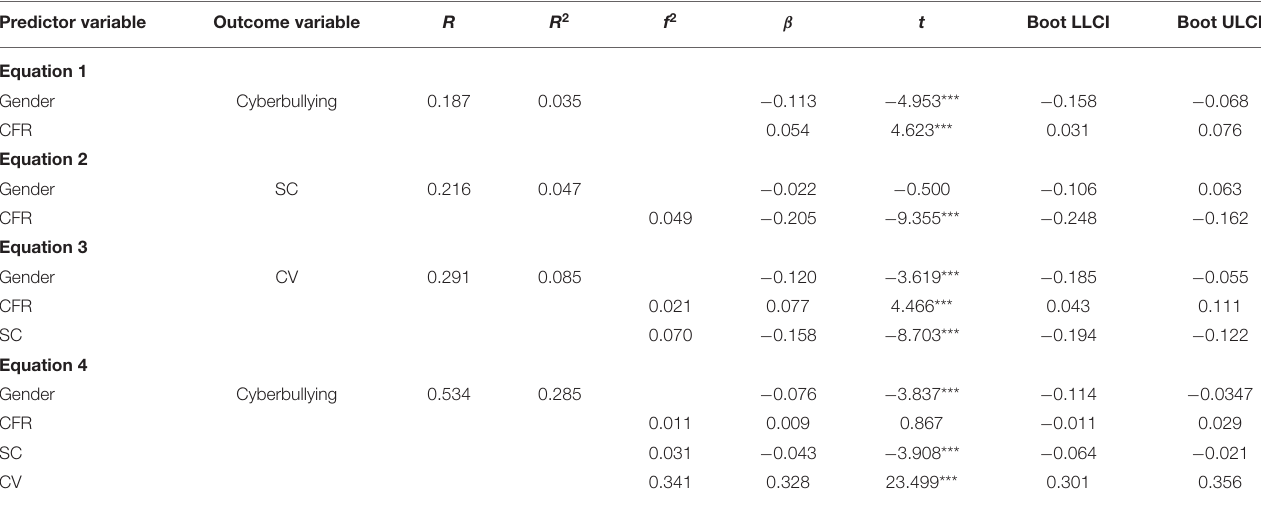
TABLE 3 | Regression results for the conditional indirect effects.